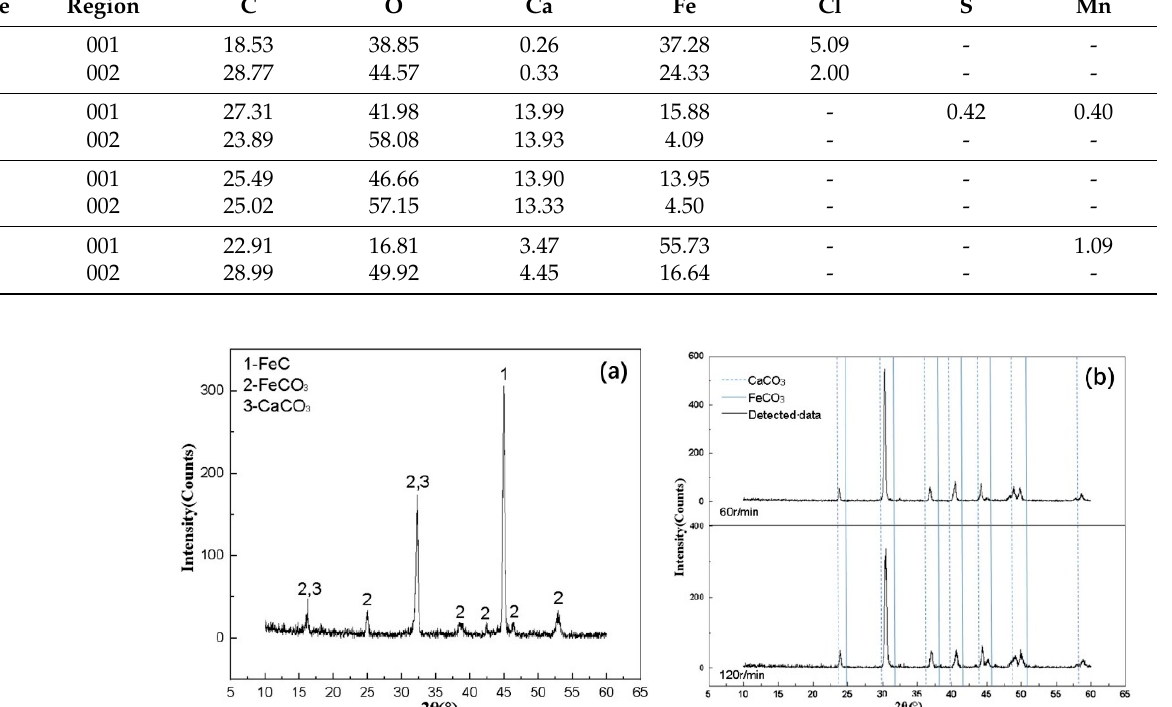
Figure 5. XRD patterns of corrosion products on the P110 steel surface at different speeds: ( a ) 0 r/min; ( b ) 60 and 120 r/min.